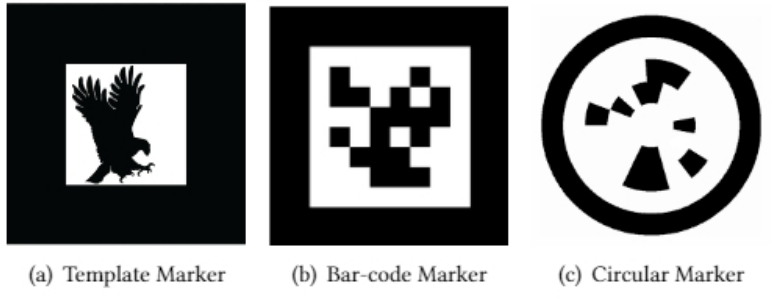
Figure 2. State-of-the-art AR